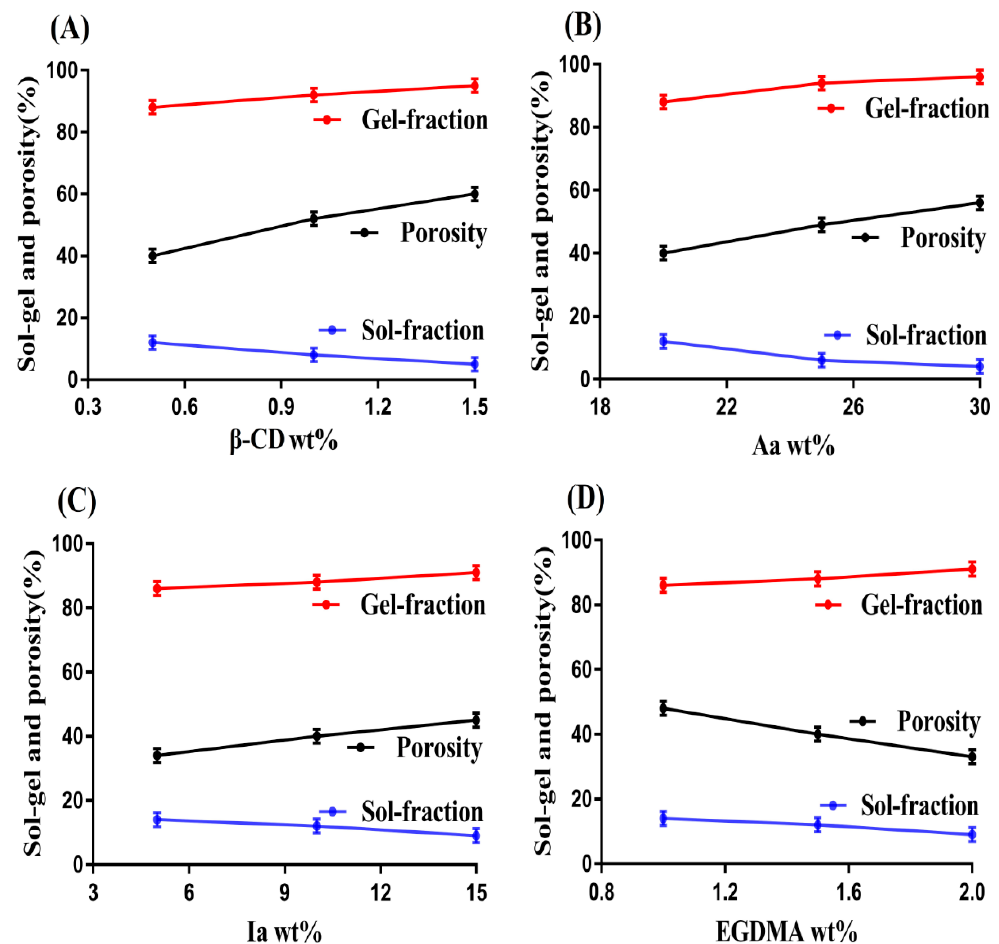
Figure 6. Effect of ( A ) β -CD, ( B ) Aa, ( C ) Ia, and ( D ) EGDMA on sol–gel and porosity of β -CD- g -P(Aa/Ia) hydrogel. P(Aa/Ia)